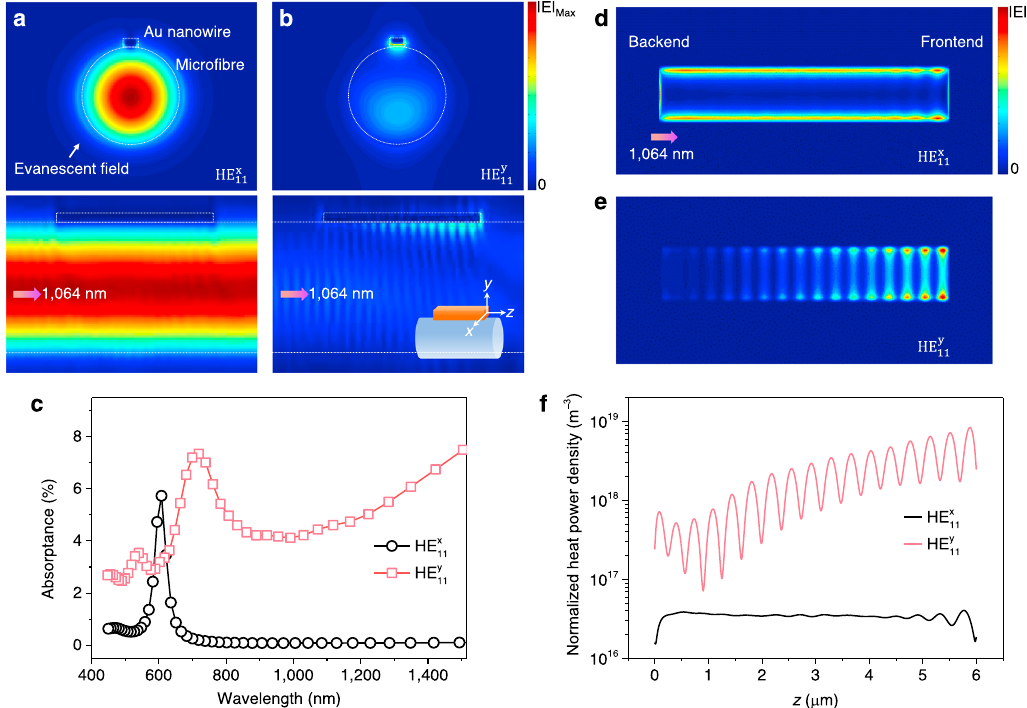
Fig. 2 Calculated distributions of electric fi elds and heat power densities in Au nanowires. a , b Electric fi eld distributions of the nanowire – micro fi bre system at the (upper images) transverse and (lower images) longitudinal sections, excited by a HE 11 x fundamental mode and b HE 11 y fundamental mode guided in the micro fi bre at 1064 nm wavelength. The Au nanowire has a thickness of 100 nm, a width of 200 nm, and a length of 6.0 μ m, and the micro fi bre has a D fi ber of 1.8 μ m. Inset of ( b ) lower image shows the de fi nition of electric fi eld directions. c Absorptance spectra of the Au nanowire with different fundamental modes. d , e Spatial distributions of heat power density on the Au nanowire bottom surface for d the HE 11 x modes and e the HE 11 y modes, respectively. f Heat power density value along the sideline ( z direction) of the nanowire bottom